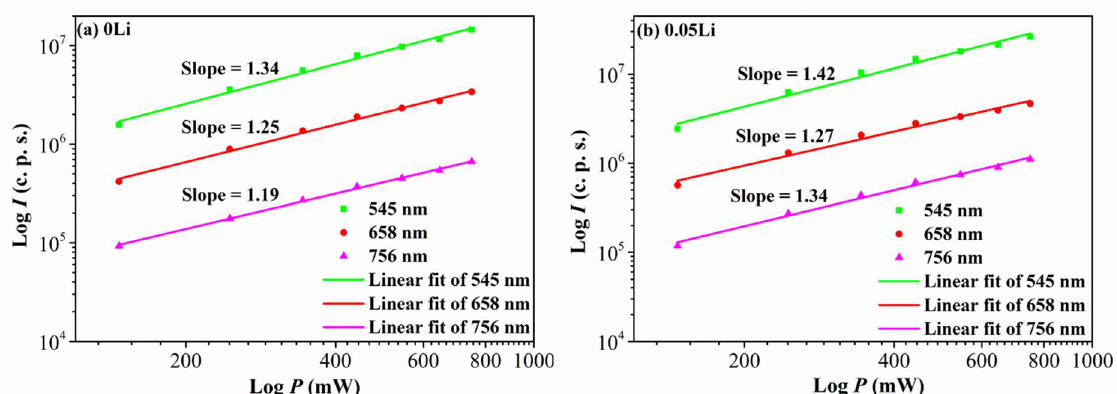
Figure 6. Log-log diagram of the dependence of UC emission intensities for green, red and near-infrared emissions on pumping power ( P ) of 980 nm excitation for ( a ) BHYTO and ( b ) BHYTO: 0.05Li samples.